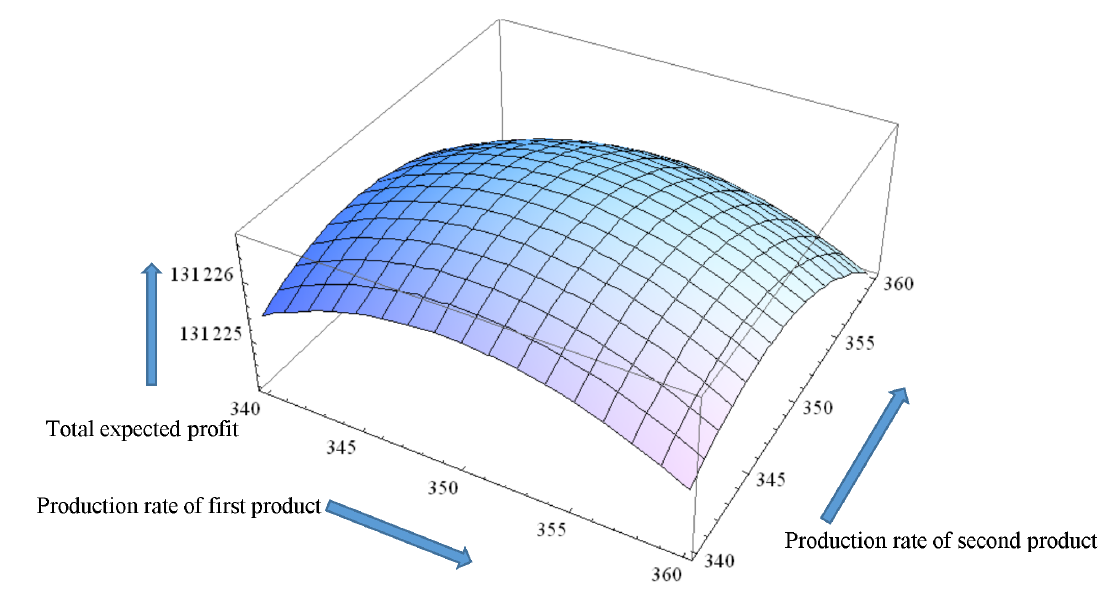
Figure 6. Expected total profit (ETP) versus production rate of two products ( P 1 , P 2 ).